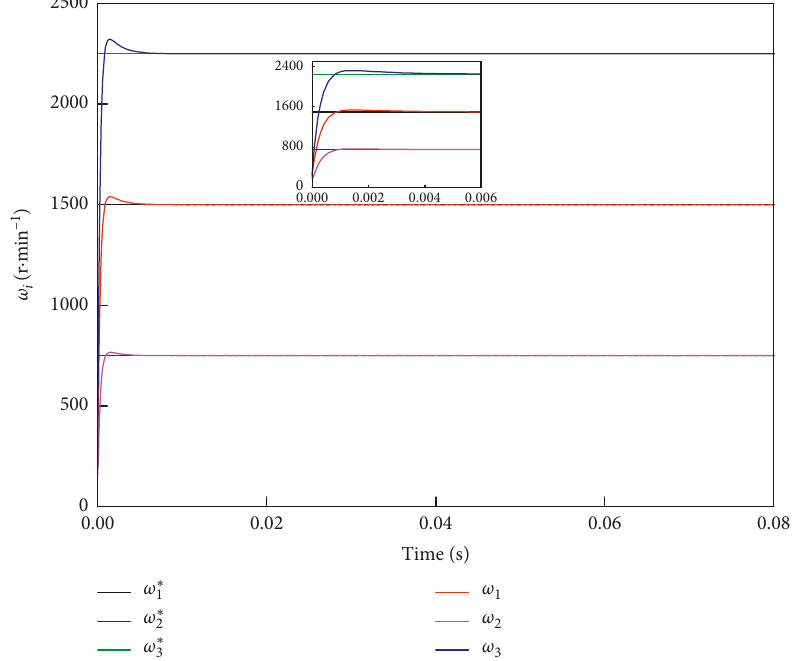
Figure 4: The velocity tracking curves of all servos under the traditional PI